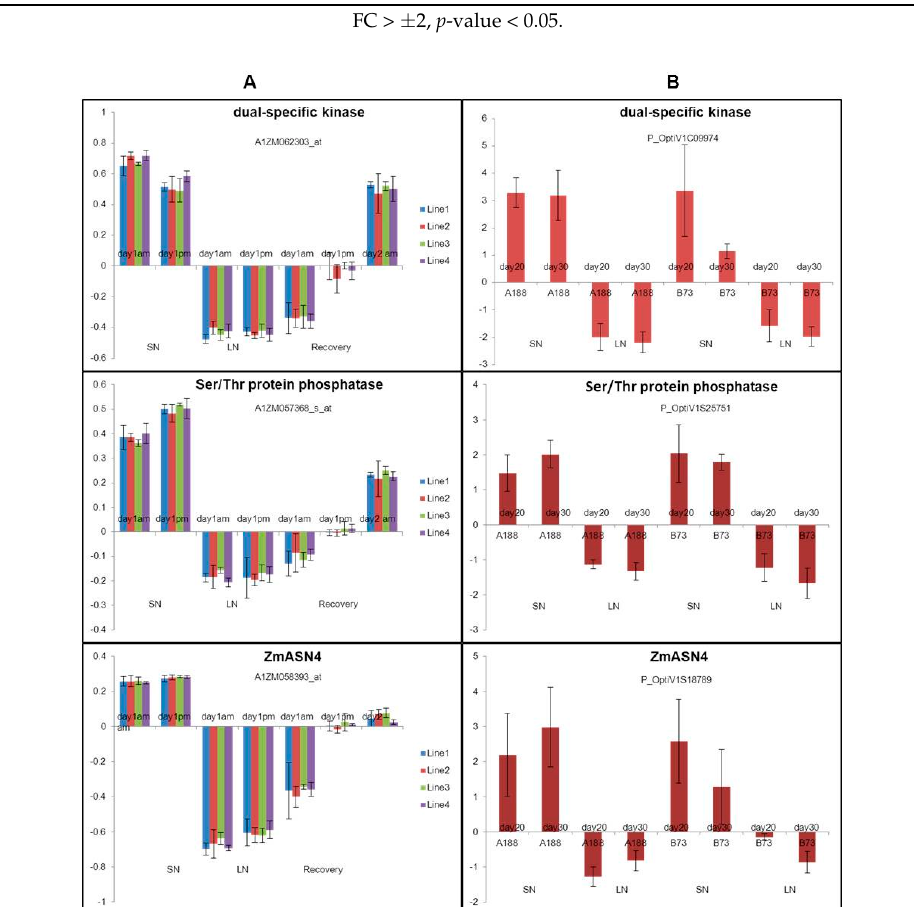
Figure 4. Expression patterns of three common genes selected from artificial neural network (ANN) across chips comparison. ( A ) Gene expression date from Study 1 [24], ( B ) Gene expression date from Study 2 [25]. Note: LN: low nitrogen; SN: sufficient nitrogen; Recovery: recovery from low N to SN.